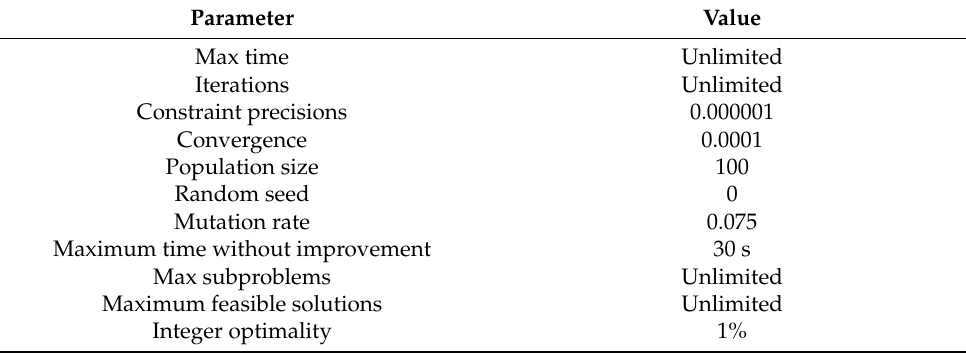
Table 3. Parameters used for optimization in the Excel